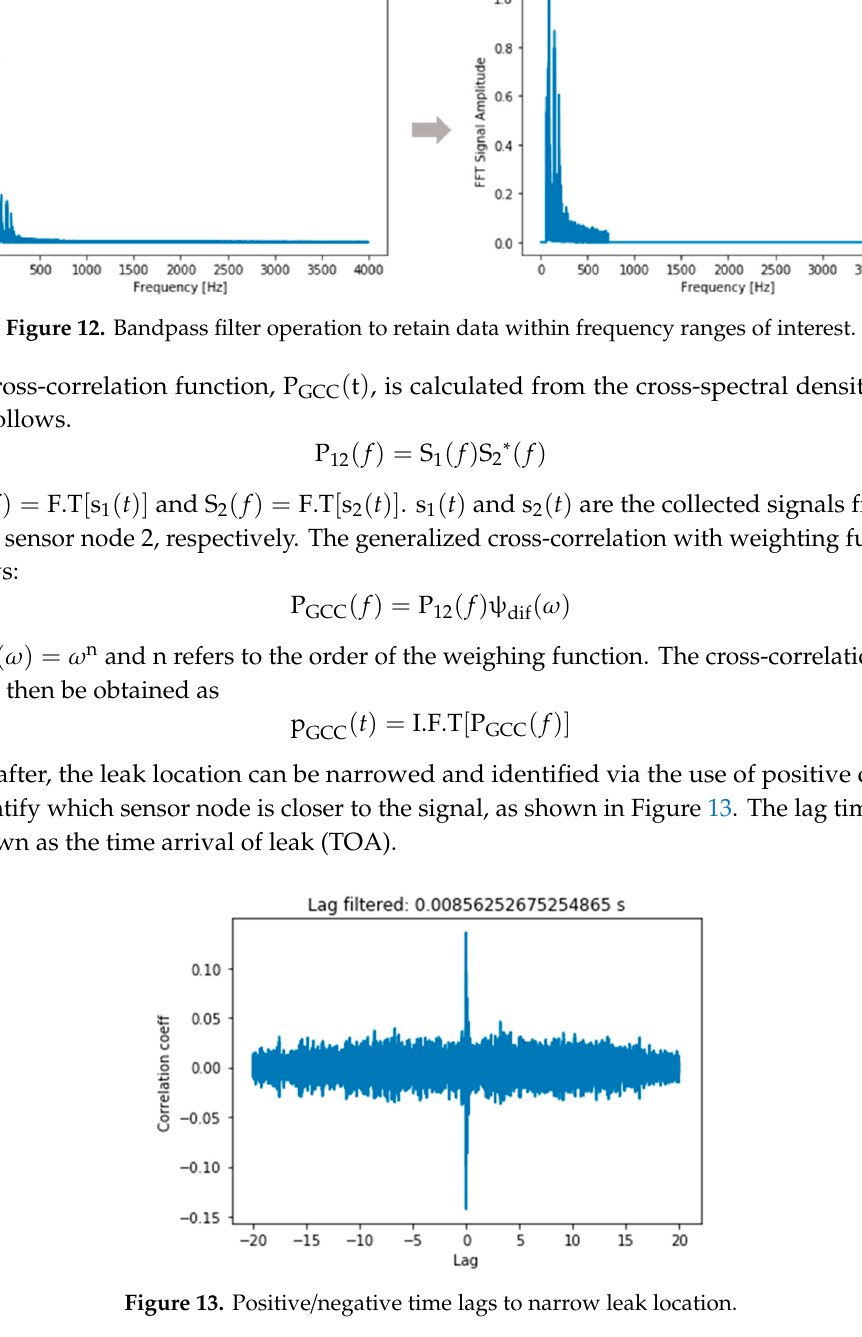
Figure 11. Isolating frequency ranges of interest using spectral centroids.